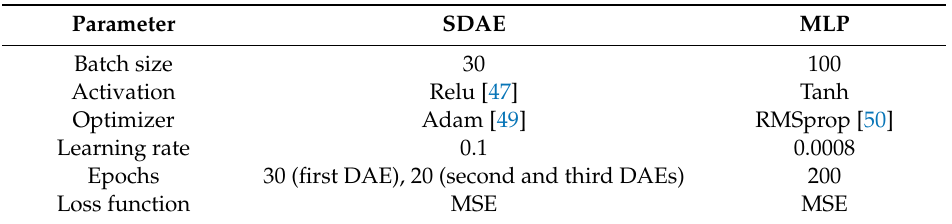
Table 1. Hyperparameter values in our proposed SDAE and MLP.